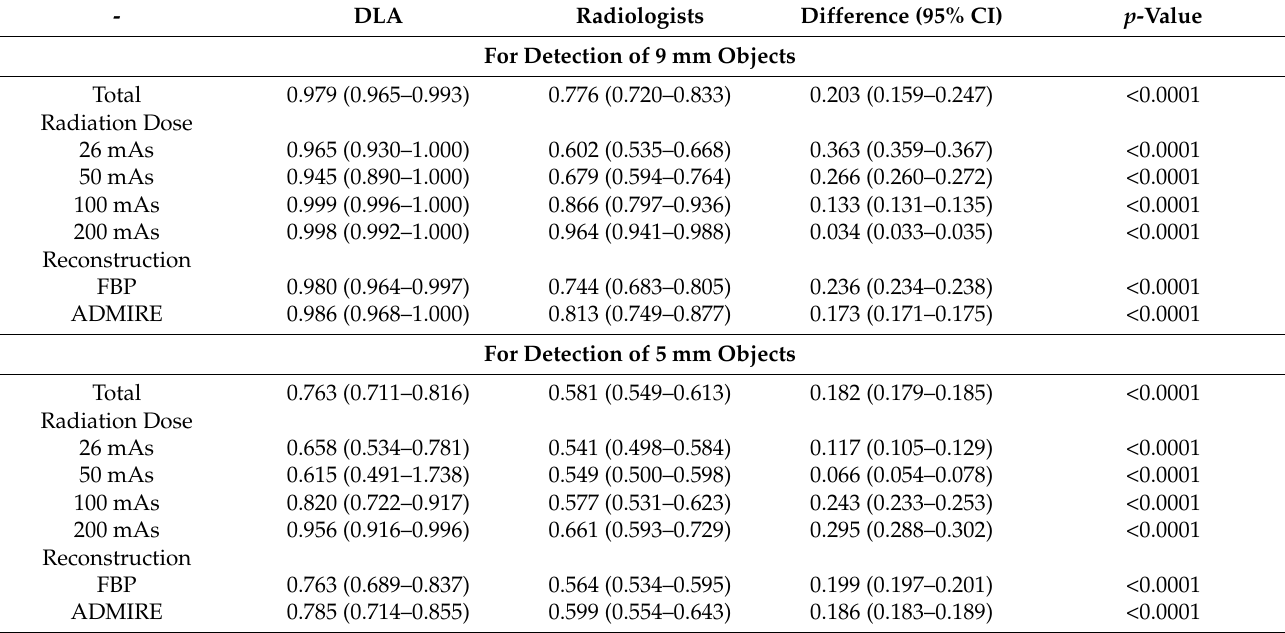
Table 3. Secondary analysis by object size.